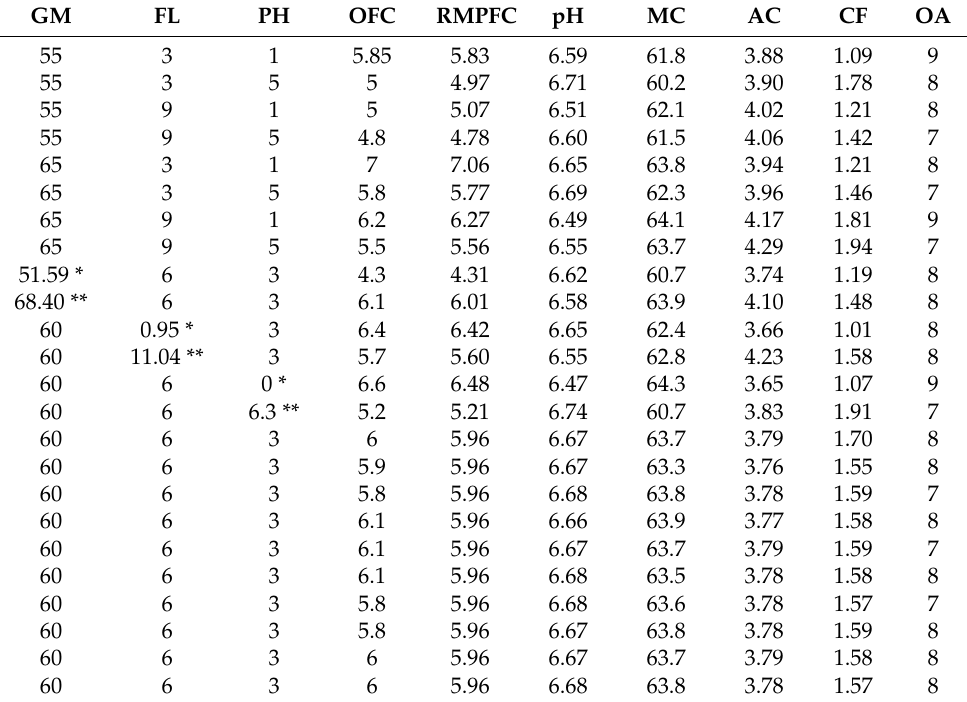
Table 1. Experimental design: central composite design (CCD), GM: goat meat (g), FL: fenugreek leaves (g), PH: psyllium husk (g), OFC: observed fat content (%), REPFC: response model-predicted fat content (%), MC: moisture content (%), AC: ash content (%), CF: crude fiber (%), OA: overall acceptability.